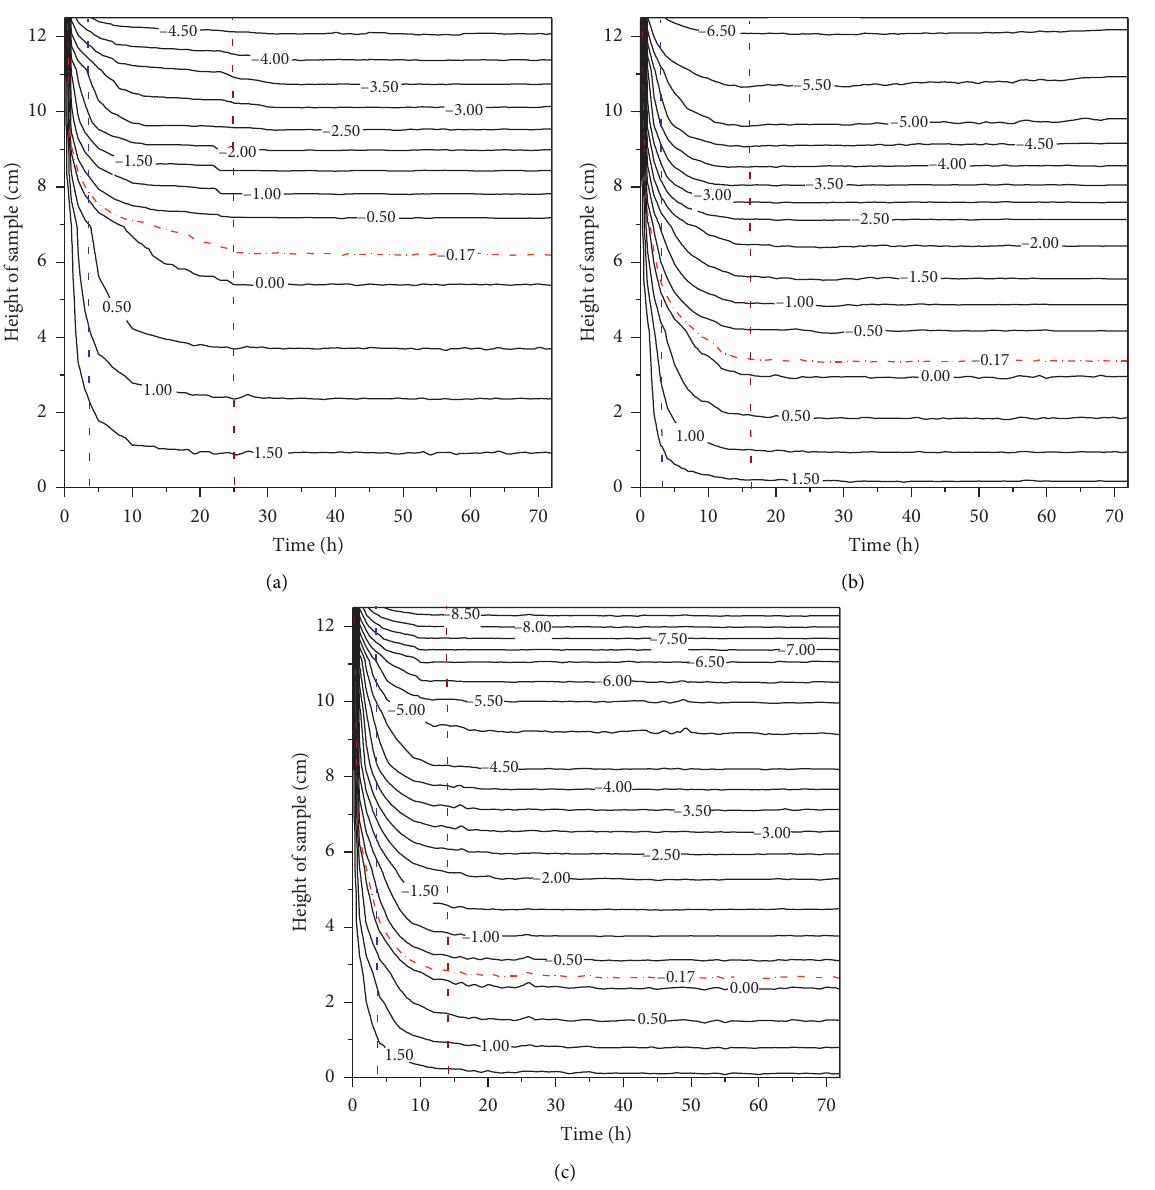
Figure 3: The temperature changes in soil samples under different top-plate temperatures. (a) T (b) T top � − 7 ° C, ρ d � 1.75 g ∙ cm − 3 , and ω � 17%; (c) T top � − 9 ° C, ρ d � 1.75 g ∙ cm − 3 , and ω �